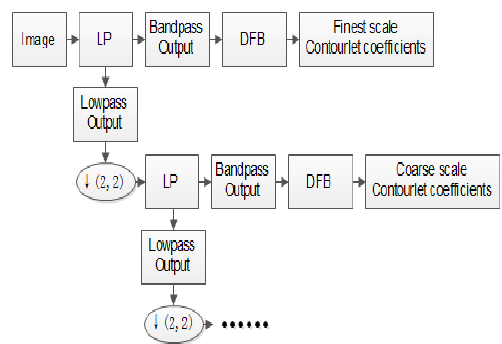
Figure 2. The Contourlet transform diagram